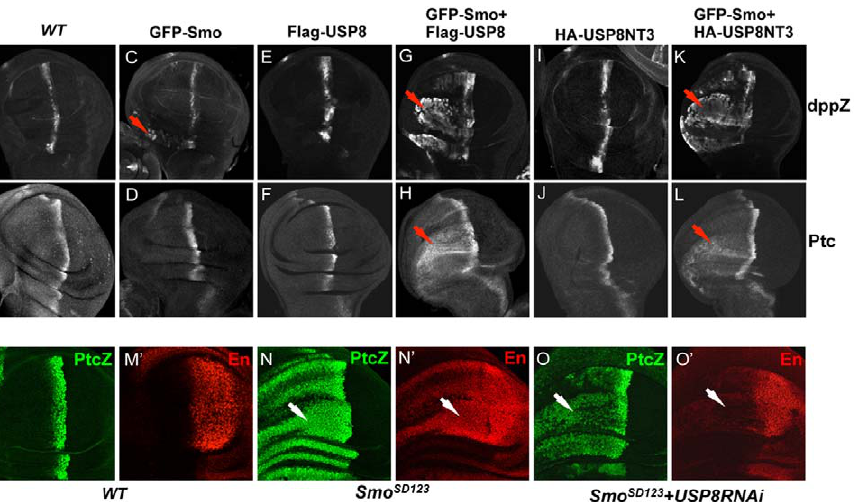
Figure 7. USP8 promotes Smo signaling activity. (A–B) Wild-type wing discs were stained with anti- b -Gal and anti-Ptc antibodies to show dpp- lacZ and endogenous Ptc expression, respectively. (C–L) Wing discs expressing GFP-Smo alone (C–D), Flag-USP8 alone (E–F), GFP-Smo and Flag-USP8 together (G–H), HA-USP8NT3 alone (I–J), or GFP-Smo and HA-USP8NT3 together (K–L) by MS1096 Gal4 were stained for dpp-LacZ or Ptc. The red arrows indicate the ectopic expression of either dpp-lacZ or Ptc. (M–M 9 ) A wild-type wing disc was immunostained for ptc-lacZ and En. (N–O 9 ) Wing discs expressing Smo SD123 alone or together with USP8RNAi by MS1096 Gal4 was immunostained for ptc-lacZ and En. Knockdown of USP8 by RNAi attenuated the ectopic ptc -lacZ expression (arrow in O) and greatly reduced the ectopic en expression (arrow in O 9